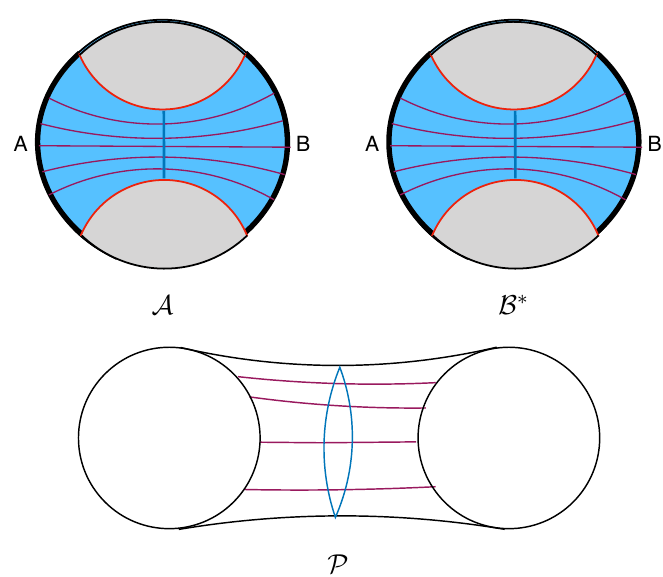
Figure 6 . We start with a copy of the entanglement wedge A and place on it the entanglement wedge cross section b p ( A ) and the maximal flow v A . Taking the CPT conjugate we create a second copy B ∗ and place on it b p ( B ) and v B . In this simple bipartite case we can take b p ( A ) = b p ( B ) and v A = v B . This will not be necessarily true in the multipartite case. Now we can glue O together identifying the surfaces on A and B ∗ . This creates the purified manifold P . Using the original cross sections and flows, we can identify the new entanglement wedge cross section and a maximal flow on P . Since these were minimal (maximal) respectively on each copy they too are minimal (maximal) on P . This is our procedure for making “constructed” flows.